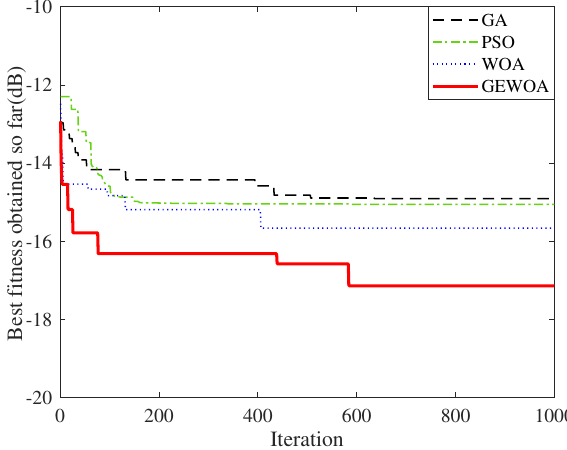
Figure 14. The iterative process of four intelligence algorithms.